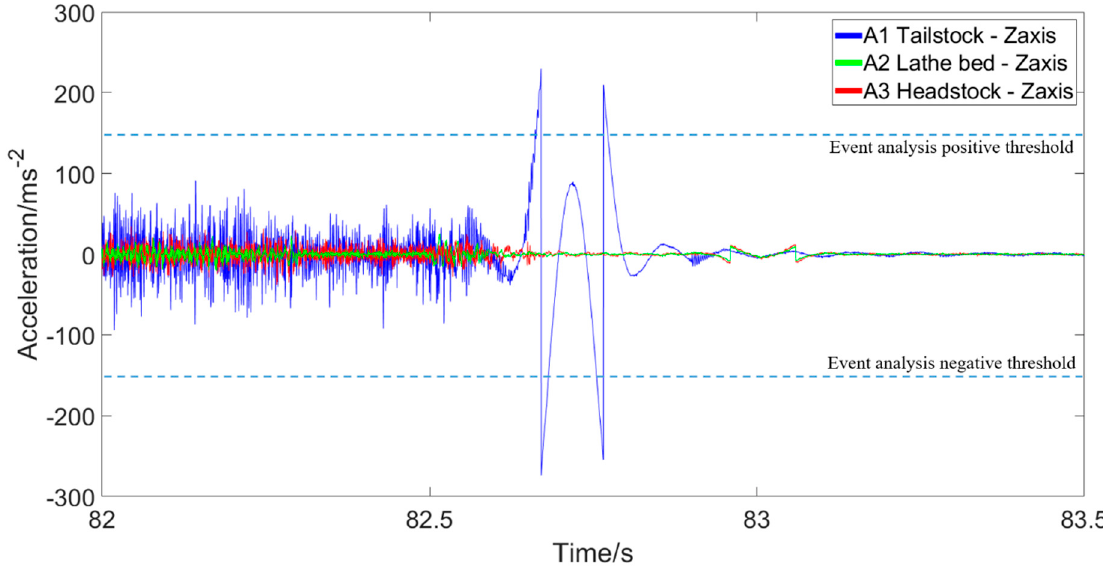
Figure 15. Example of an “event” identified by the event analysis tool, as the measured signal exceeds the user defined thresholds (dashed lines). In this example, the “event” is as a result of the brake being applied to stop the spindle after the cutting process has finished.